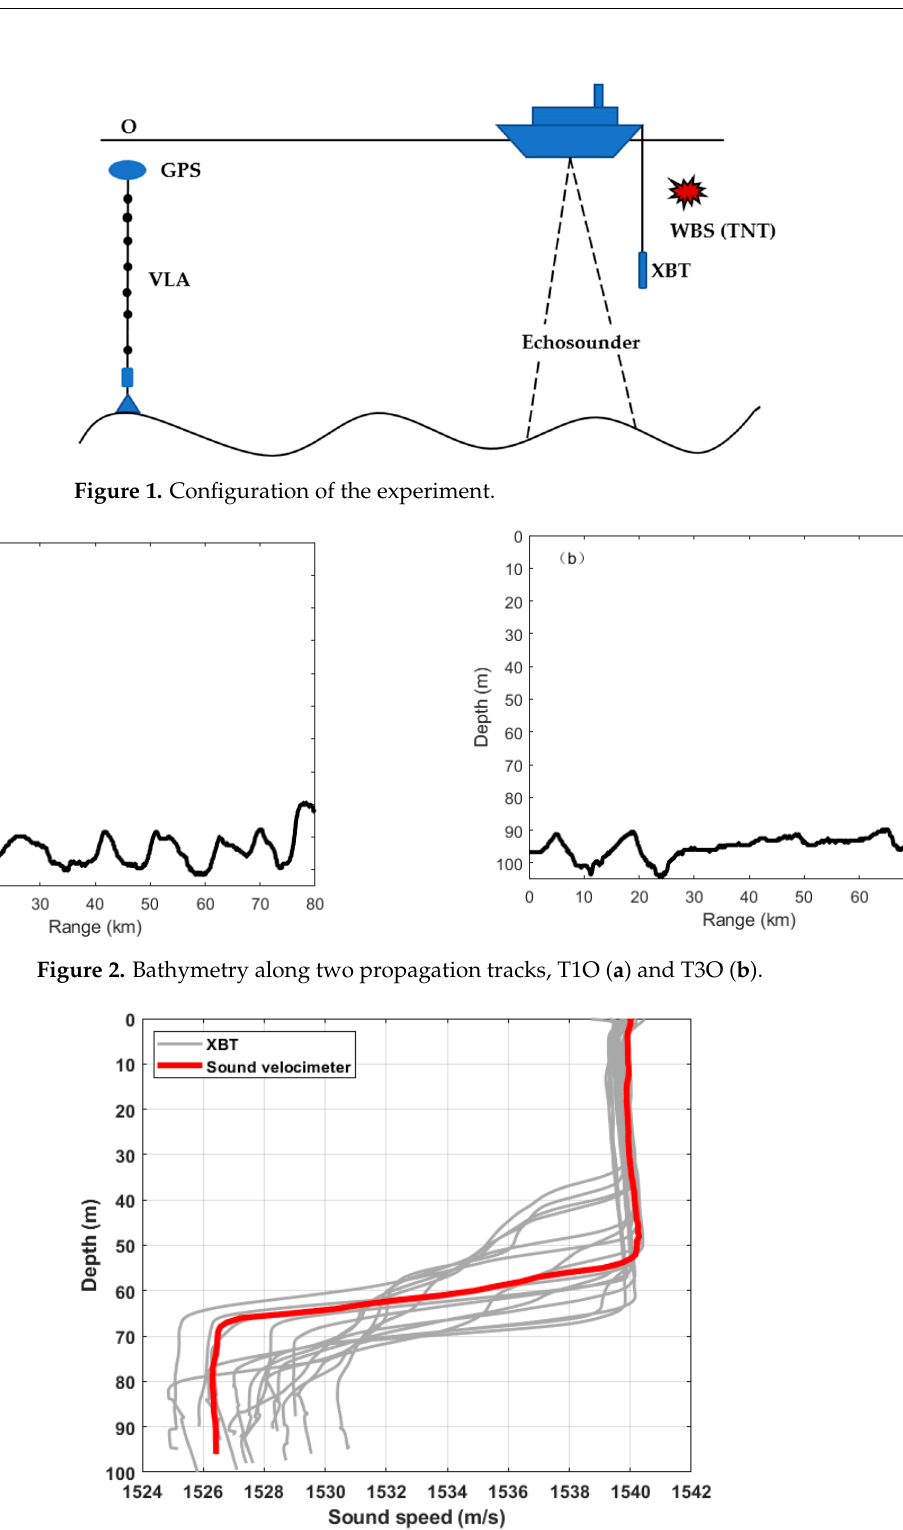
Figure 3. Sound speed profile (SSP) during the experiment.